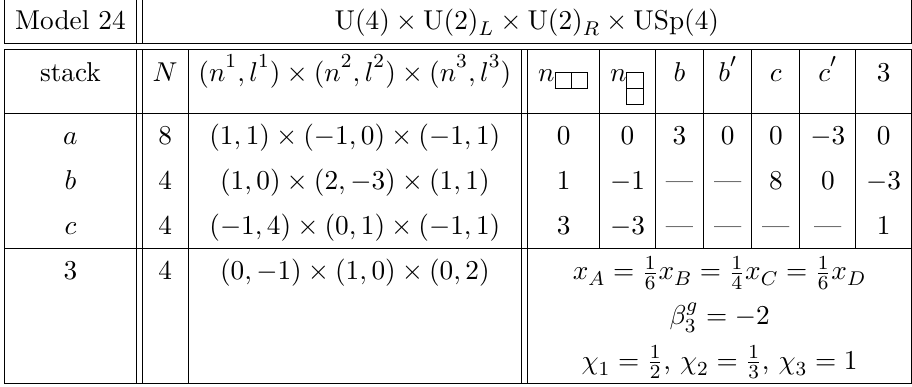
Table 31 . D6-brane configurations and intersection numbers of Model 24, and its MSSM gauge